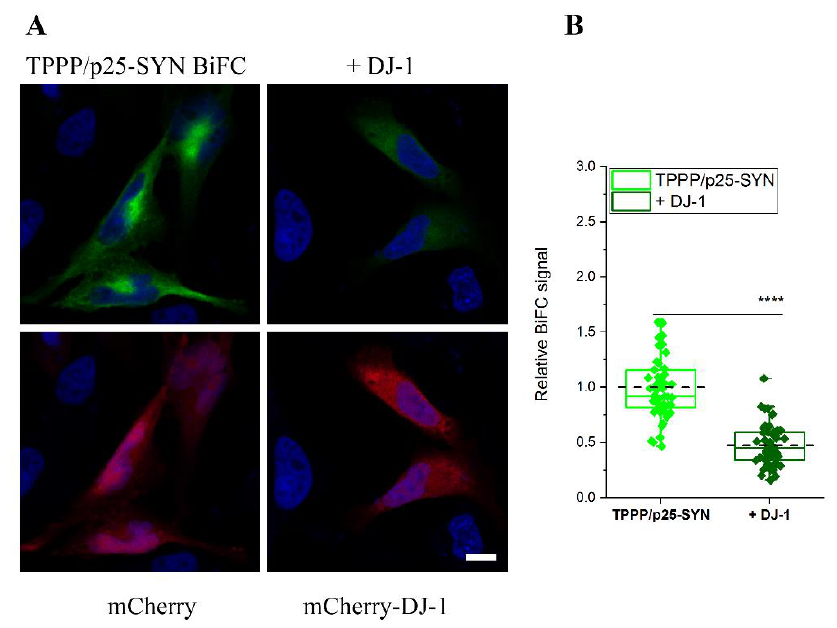
Figure 3. The effect of DJ-1 on the association of V N -SYN with V C -TPPP/p25 in a human cell line. ( A ) Representative images. V C - and V N -containing fragments of Venus were conjugated to SYN and TPPP/p25 sequences, respectively, and their plasmids were co-transfected into HeLa cells and with either mCherry (control cells) or mCherry-DJ-1 (mixture of 3 plasmids). Nuclei, blue (Hoescht 33342). Bar: 5 µ m. ( B ) Quantification of the BiFC signal based on the individual cell fluorescence as described in the Material and Methods. Box extends from the 25th to 75th percentile with the middle solid green and the dashed black lines representing the median and the mean, respectively (n = 49 for TPPP/p25-SYN, n = 54 for + DJ-1). Statistical comparison was performed with one-way ANOVA followed by Tukey’s test (**** p <